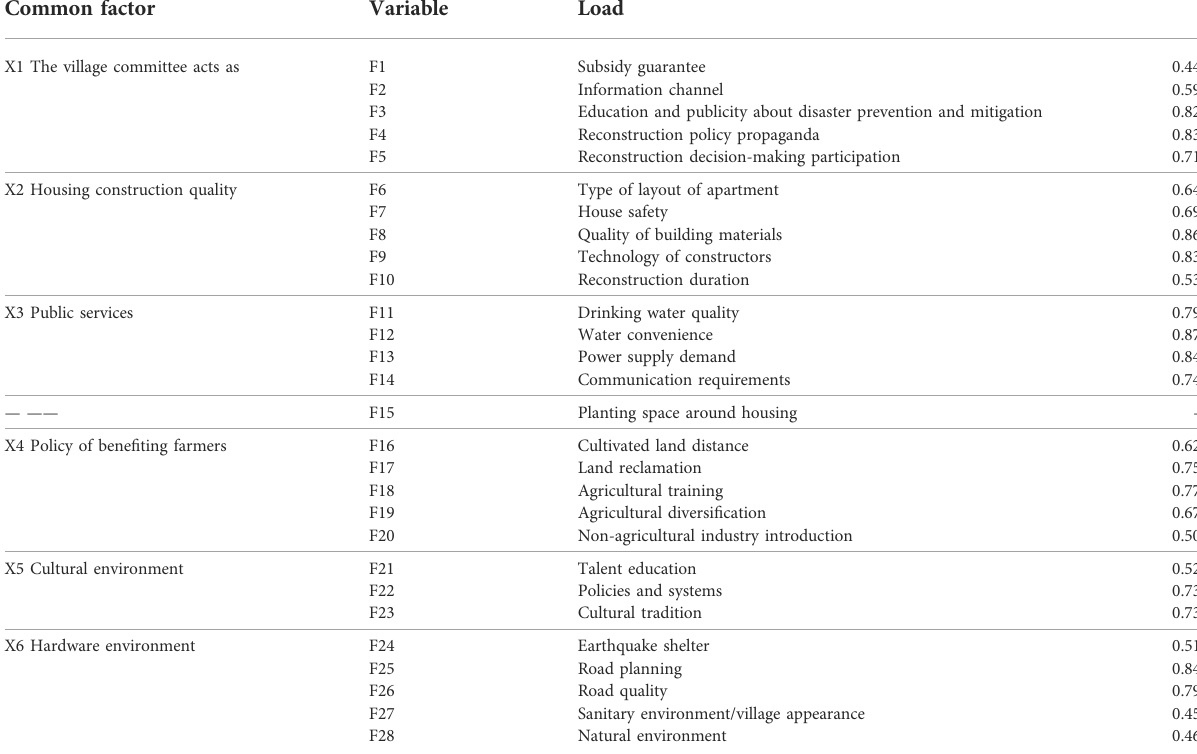
TABLE 6 Molecular results of exploratory